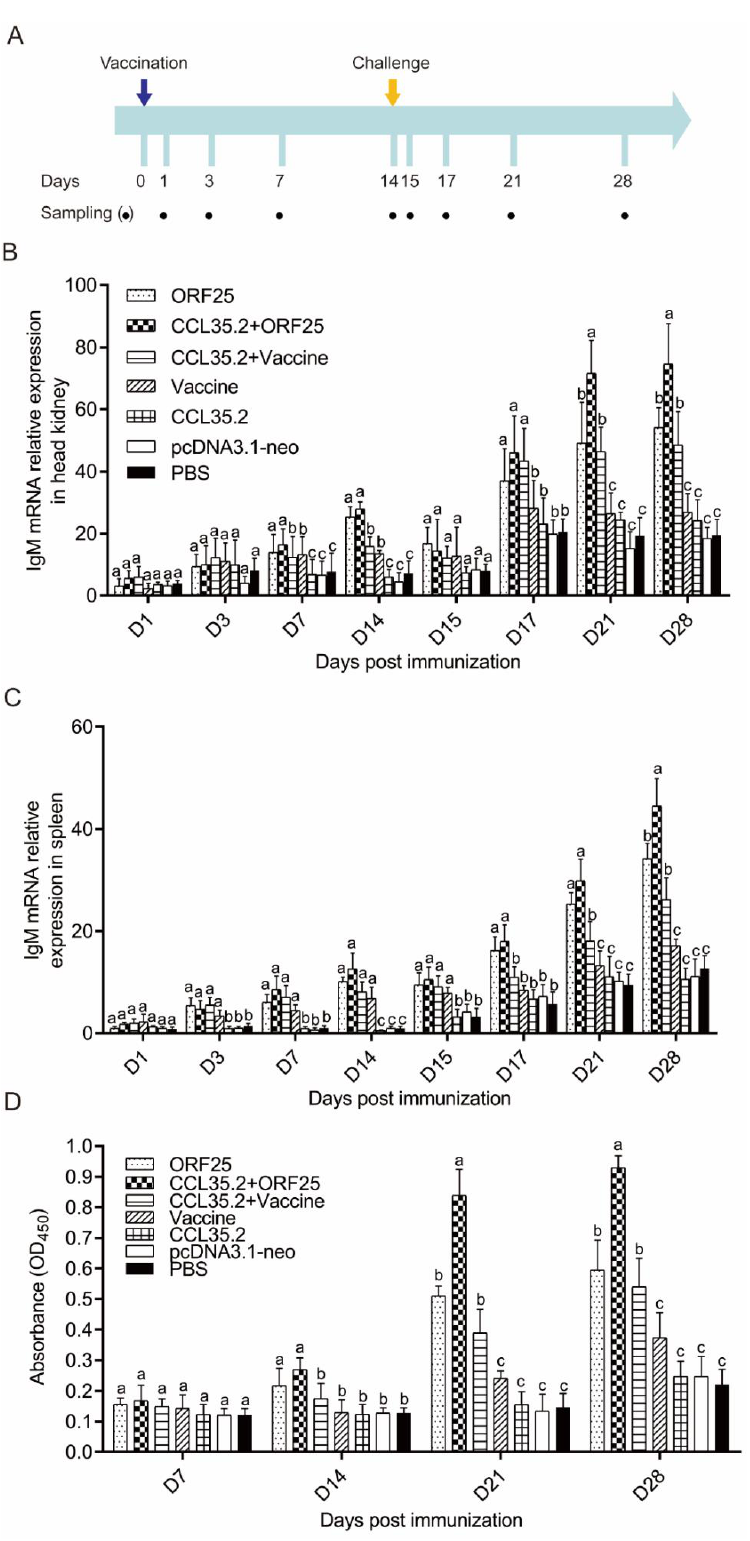
Figure 4. IgM levels in tissue and serum. ( A ) Vaccination / challenge and sampling schedule. mRNA expression patterns of IgM in head kidney ( B ) and spleen ( C ) were determined by qRT-PCR. β